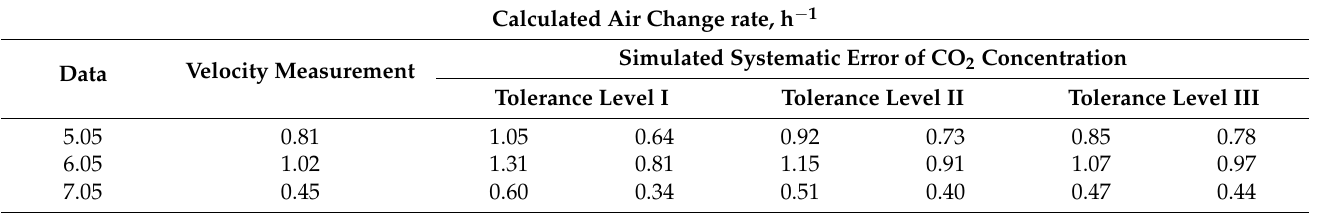
Table 2. Analysis of systematic errors of measured CO 2 concentration on estimated air change rate.